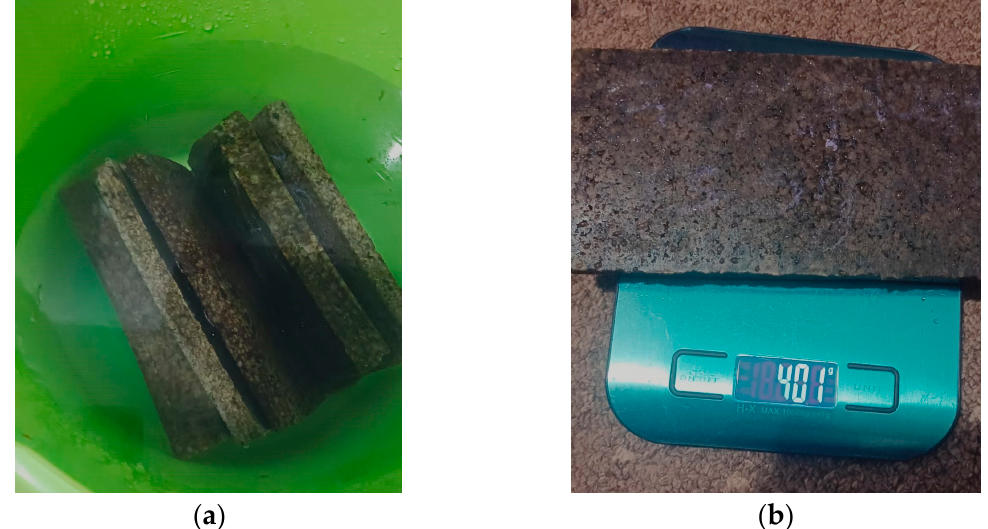
Figure 8. Performing the water absorption test. ( a ) Bricks immersed in water. ( b ) Weight check after 24 h.